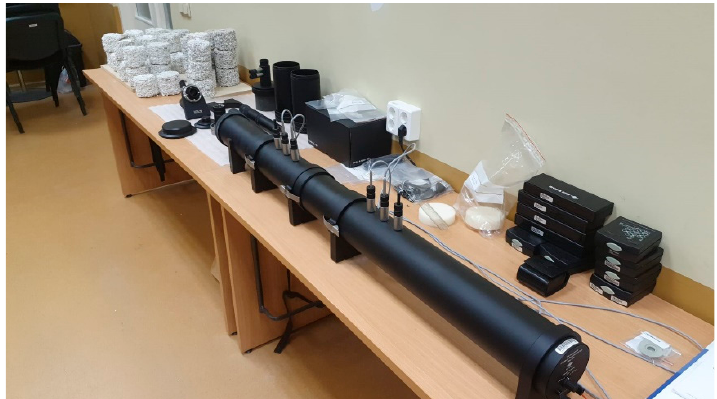
Figure 9. Testing apparatus of sound absorption coefficient.